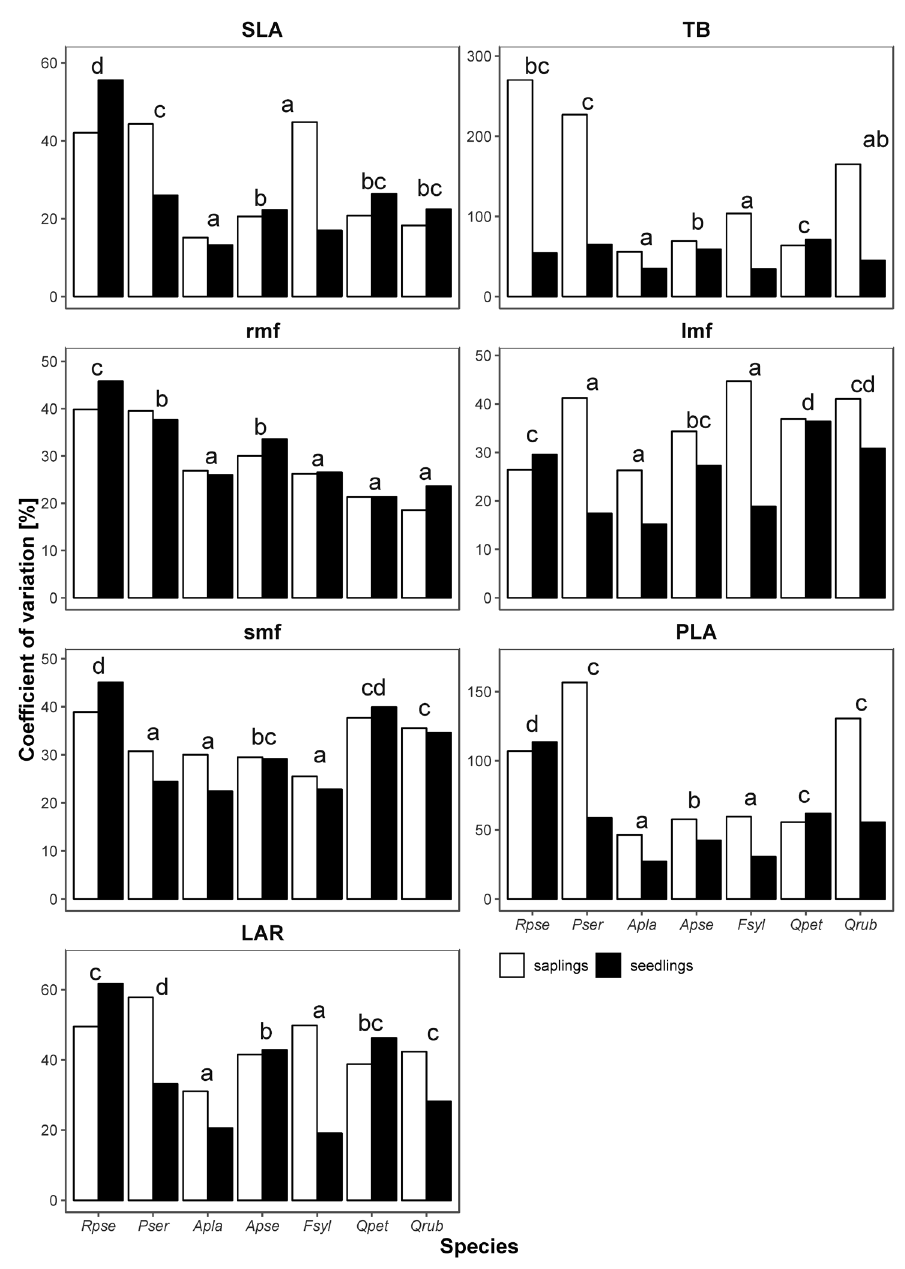
Figure 3. Coefficients of variation for age stages and parameters: SLA – specific leaf area (cm 2 g -1 ), TB – total biomass [g], rmf – root mass fraction, lmf – leaf mass fraction, smf – stem mass fraction, PLA – projected leaf area [cm 2 ], LAR – leaf area ratio [cm 2 g -1 ]. The same letters species which did not differ statistically significantly (p>0.05) in pairwise comparisons by modified signed-likelihood ratio (M-SLR) tests of differences. Tests revealed the same division into species groups for both saplings and